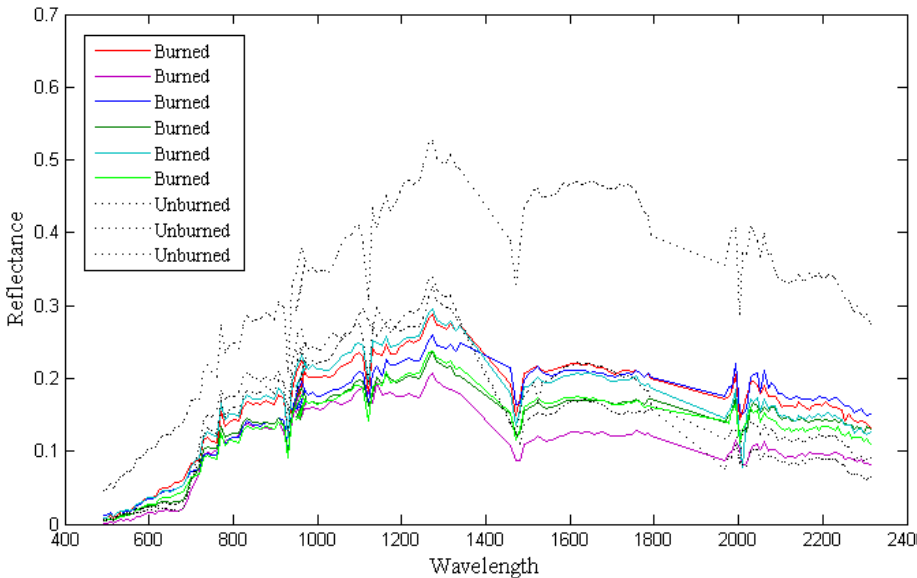
Figure 12. Spectral signatures among the burned and unburned